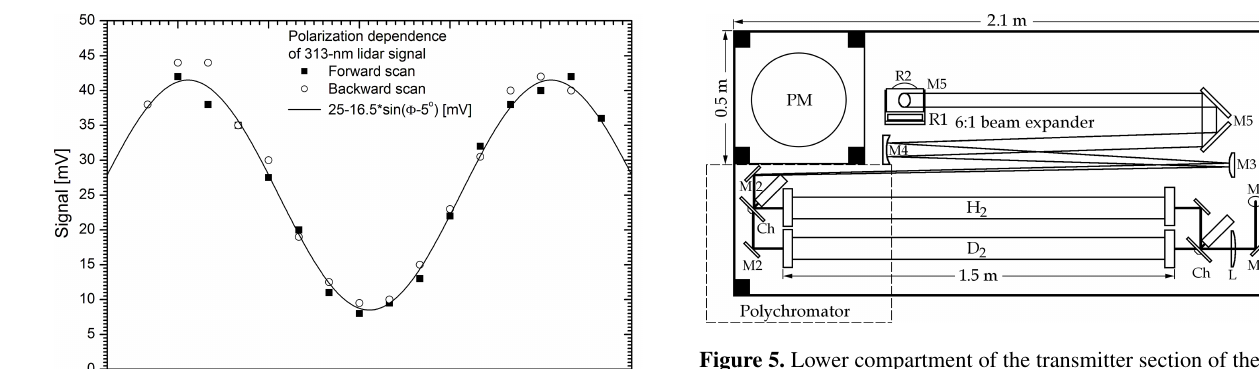
Figure 5. Lower compartment of the transmitter section of the mo- bile DIAL; the 266nm beam enters vertically from the top compart- ment and hits the first of the two M1 mirrors. The polychromator is located above the two compartments as indicated by the broken line. Abbreviations are as follows. M1: high-reflecting mirror for 266nm; M2: high-reflecting mirror for at least 266–300nm; Ch: ro- tating beam splitter (“chopper”); L: f = 1 . 00m, AR-coated; M3: curved mirror, f = − 0 . 20m, HR-coated for at least 266–300nm; M4: curved mirror, f = − 0 . 20m, coated for at least 266–300nm; M5: rectangular mirrors, high-reflecting mirror for at least 266– 300nm; R1, R2: motorized rotation stages, mounted vertically and horizontally,